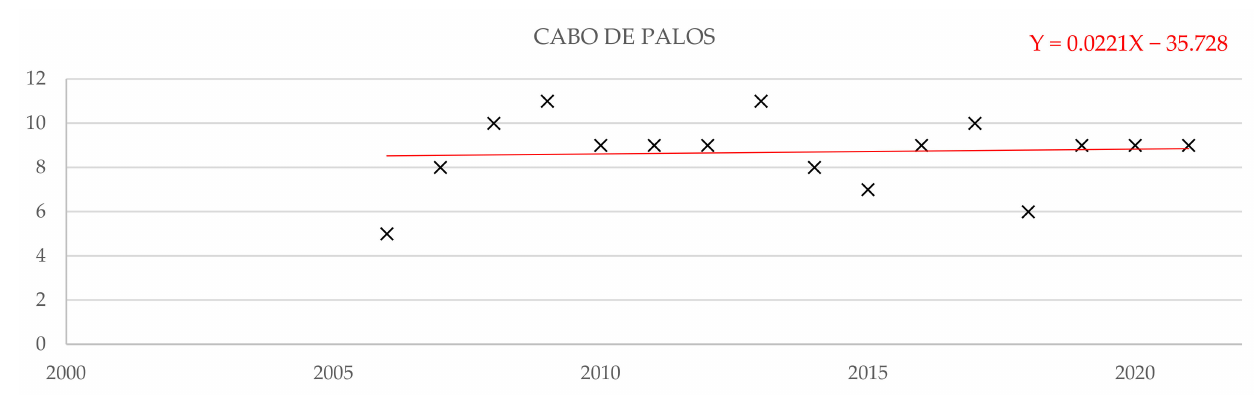
Figure 21. Number of times Hs has exceeded the threshold in Gata.